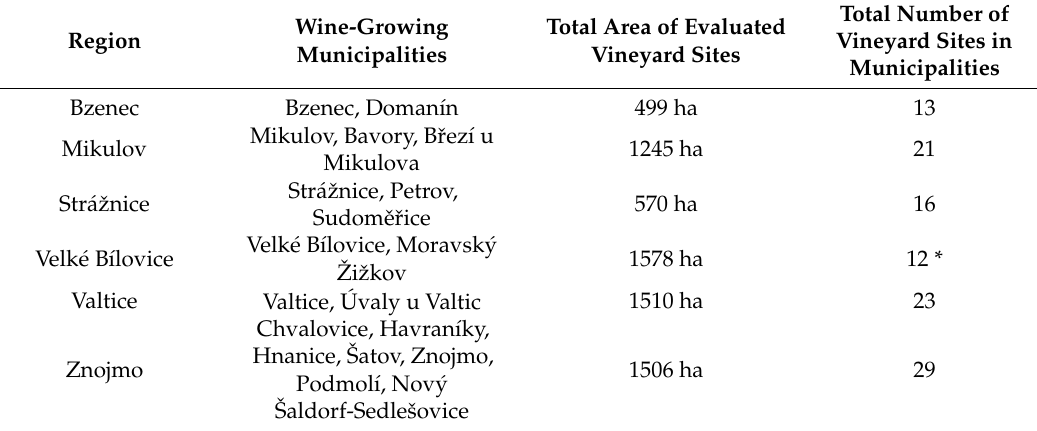
Figure 1. Location of the Czech Republic and South Moravian Region (SM) ( a ) and location of evaluated vineyard sites in 6 regions within SM ( b ) [26,27]. Table 1. Evaluated vineyard sites sorted by wine-growing municipalities .